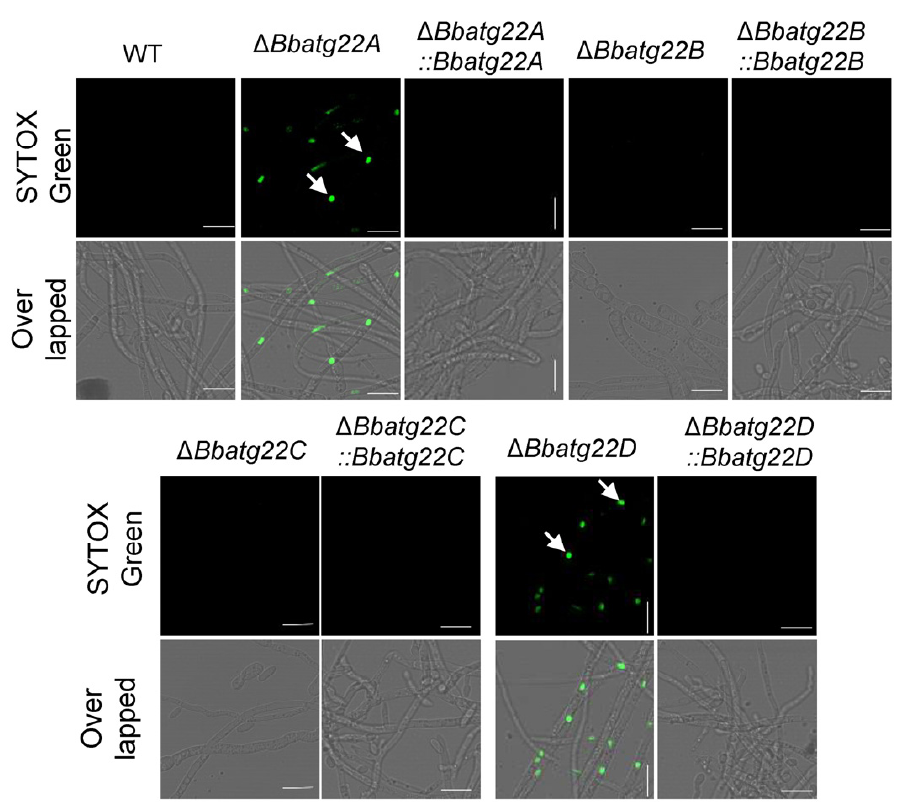
Figure 4. Assays for membrane integrity. Conidial suspension was inoculated into SDB and cultured at 25 ◦ C for 2 d. The resultant mycelia were stained with SYTOX Green (nucleus-specific dye), and the fluorescent signals were examined under a fluorescent microscope. Green signals were observed in most nuclei in mycelia of ∆ Bbatg22A and ∆ Bbatg22D (indicated with arrows). Scale bars: 10 µ m.